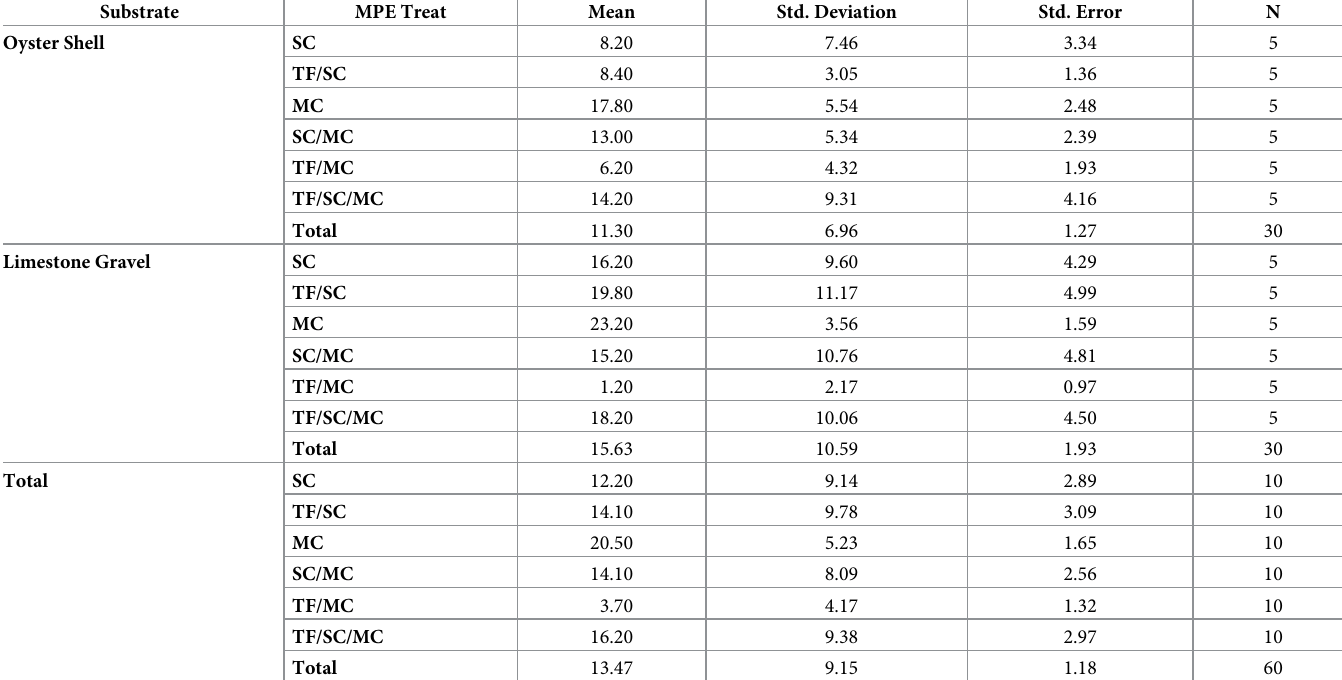
Table 2. Numbers of oysters consumed for MPE experiment treatments for oyster shell and limestone gravel, as well as totals across treatments and substrates (maximum of 30 possible). Substrate